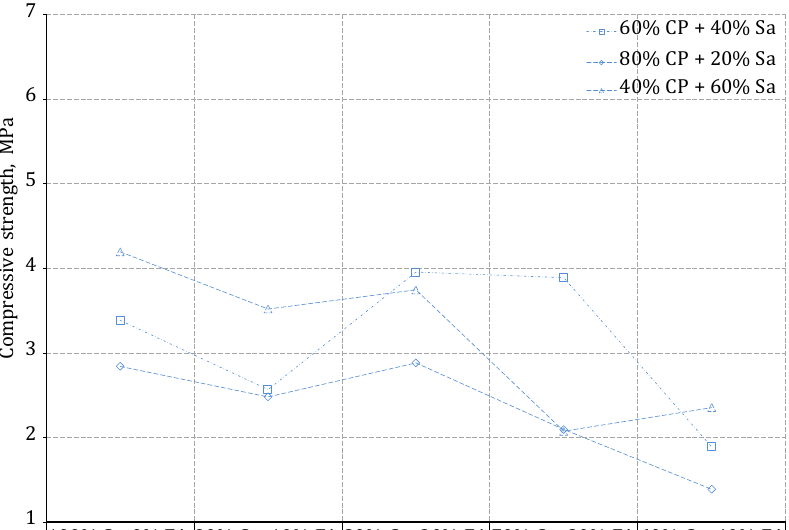
Figure 4. Fly ash effect on strength after 7 days (Zakarka et al., 2019)